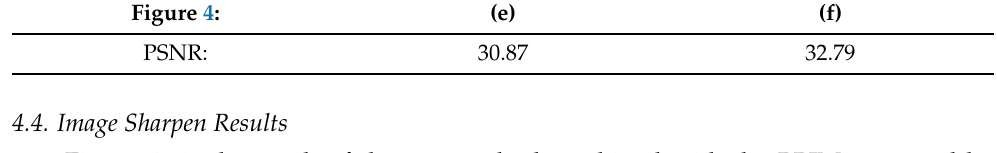
Table 1. PSNR results of image dilation. Figure